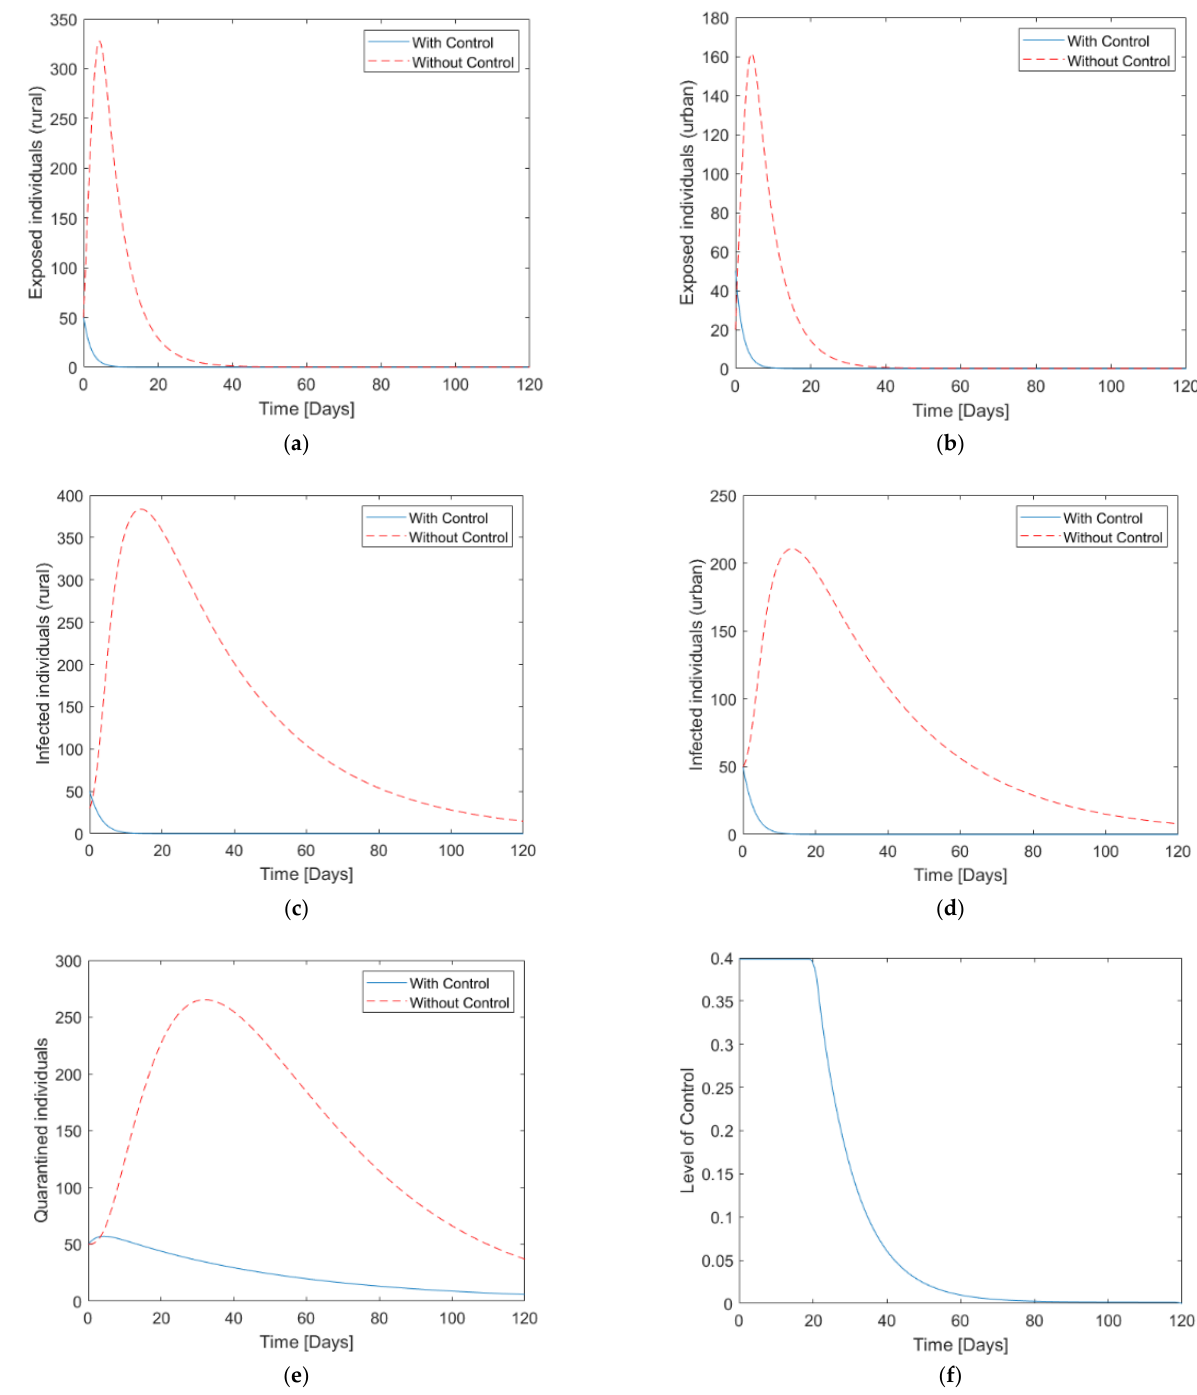
Figure 2. Comparisons between the cases without control and with control under the action of Policy 1: ( a ) Exposed individuals (rural) Eh; ( b ) Exposed individuals (rural) E h ; ( c ) Exposed individuals (urban) E l ; ( d ) Infected individuals (rural) I h ; ( e ) Infected individuals (urban) I l ; ( f ) Control effort u ( t )